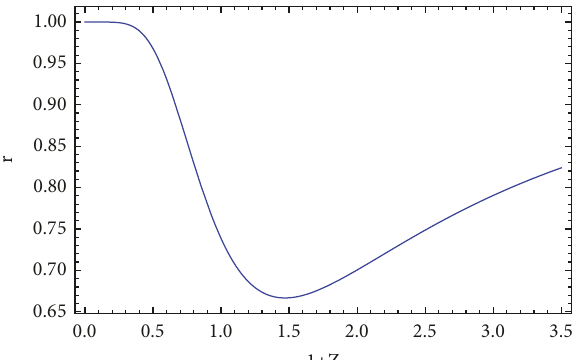
Figure 5: The evolution of the statefinder parameter 𝑟 versus the redshift parameter 𝑧 for noninteracting GDE in DGP model. Here, we have = taken Ω 𝐷 (𝑧 = 0) = 0.73 , 𝐻(𝑧 = 0) = 67 , and Ω 𝑟 𝑐